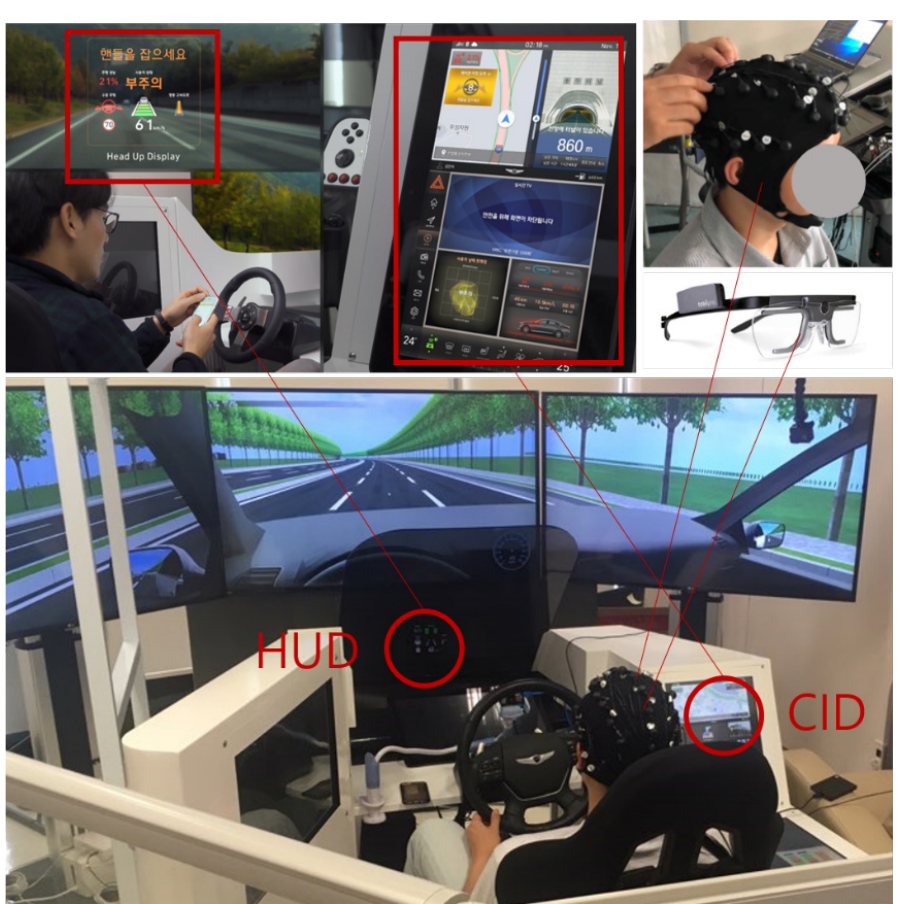
Figure 2. Alarm system and experimental equipment (driving simulator, Biobrain BIOS-S24, and Tobii Pro Glasses 2).